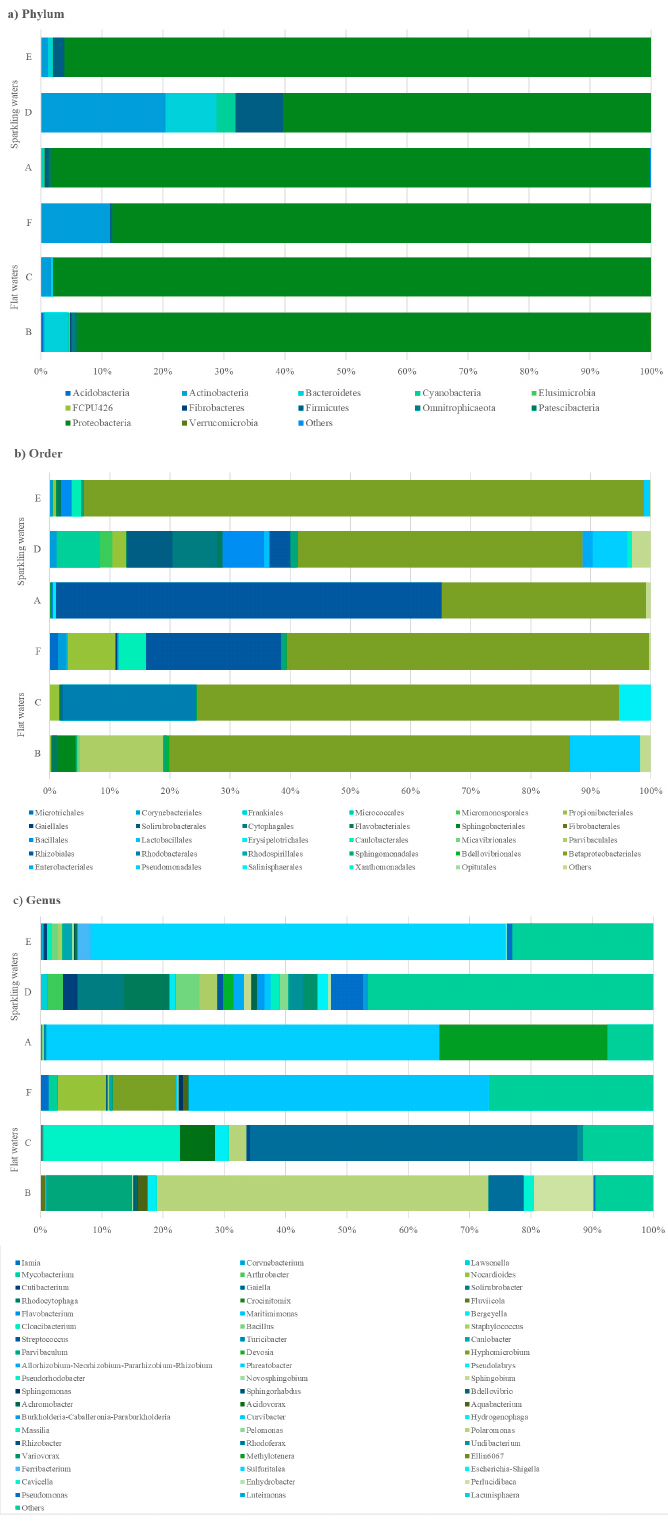
Figure 2. Community structure of the mineral water brands at Phylum ( a ), Order ( b ) and Genus ( c ) levels according to 16s rRNA sequencing analysis. Results are expressed as the relative abundance of reads. (Refer to the web version of the paper and to Figures S2–S4 in Supplementary Materials for the interpretation of colors and references in the